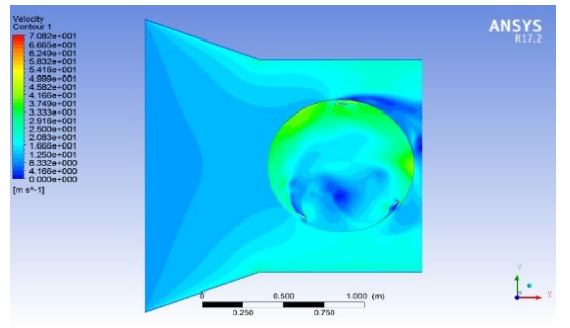
Fig. 11. Power coefficient for convergent duct wind turbine with tip speed ratio.